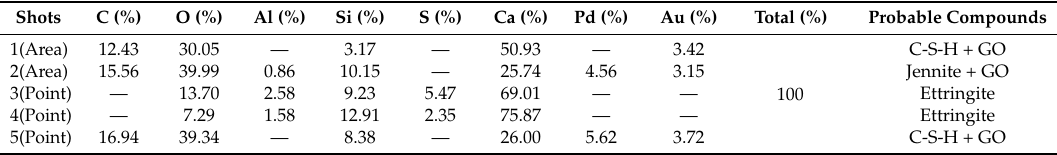
Table 6. Energy dispersive spectroscopy (EDS) analysis on GONF-cement composite (from SEM image of Figure 10b).